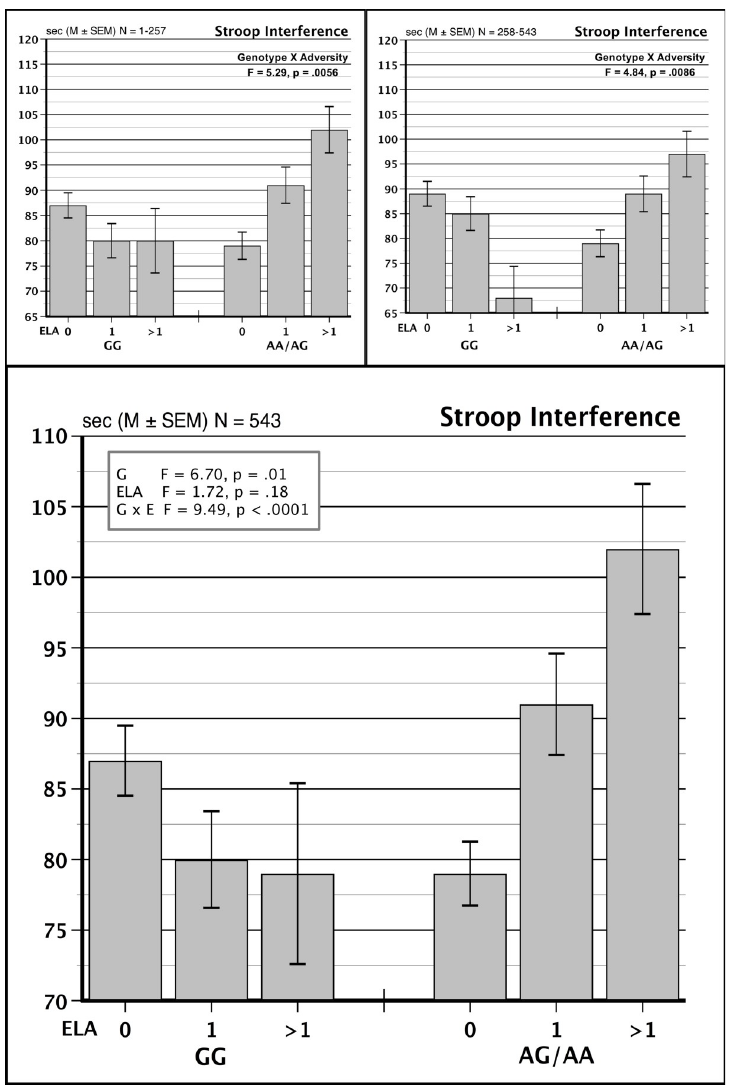
Fig 1. Stroop task interference scores for persons carrying GG and AG/AA genotypes of FKBP5 (rs9196158) who were exposed to 0, 1, or > 1 forms of ELA during childhood and adolescence. Upper left panel shows results for the initial sample of 257 subjects previously published [23]. Upper right panel shows results for the new sample of 286 subjects. Lower panel results for the combined sample of 543